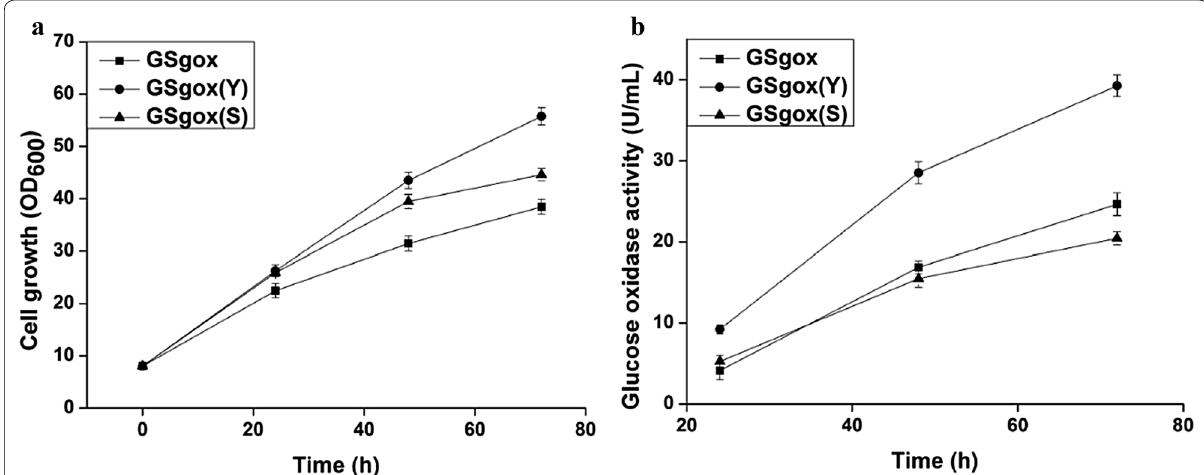
Fig. 2 Effects of co-feeding strategies on Gox expression. a Cell growth profile. b Gox activity profile. (Y) Co-feeding with yeast extract. (S) Co-feeding with sorbitol. Sole methanol feeding (square), methanol/yeast extract (circle), and methanol/sorbitol (triangle). Three parallel flasks are tested for each strain at 30 °C. Error bars represent deviations ( n 3) =